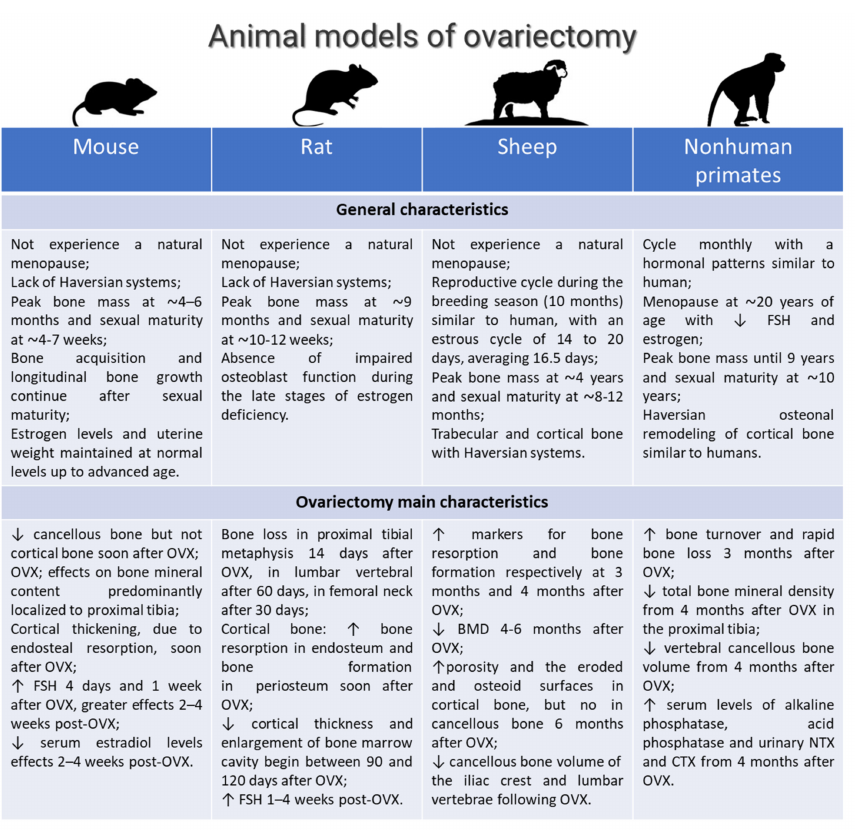
Figure 2. Main characteristics and principal OVX features of the most common animal models of postmenopausal osteoporosis [5–7,9–20]. ↑ : increase; ↓ :